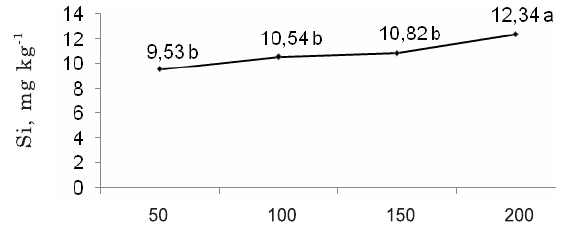
Figura 7. Teores médios de silício no solo para as ofer- tas de forragem. Teores acompanhados de mes- ma letra não diferem estatisticamente entre si pelo teste de